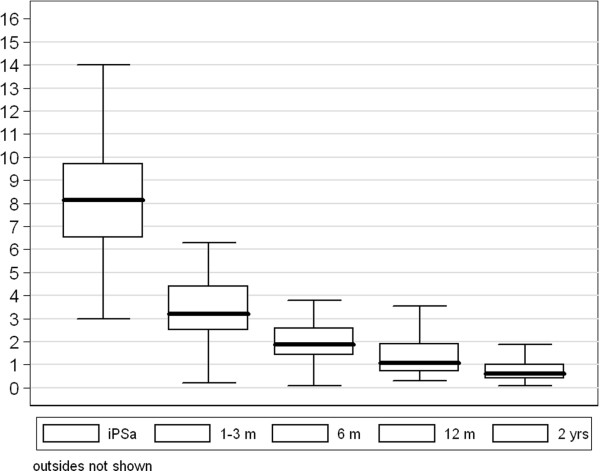
PSA. PSA response (outsides not shown).